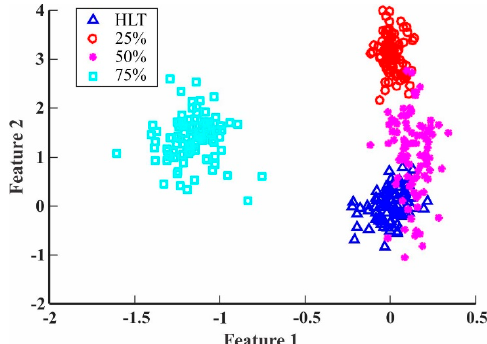
Figure 8. Projection of features, reduced by LDA, that characterize the condition of the gears onto the data set of vibration signals.